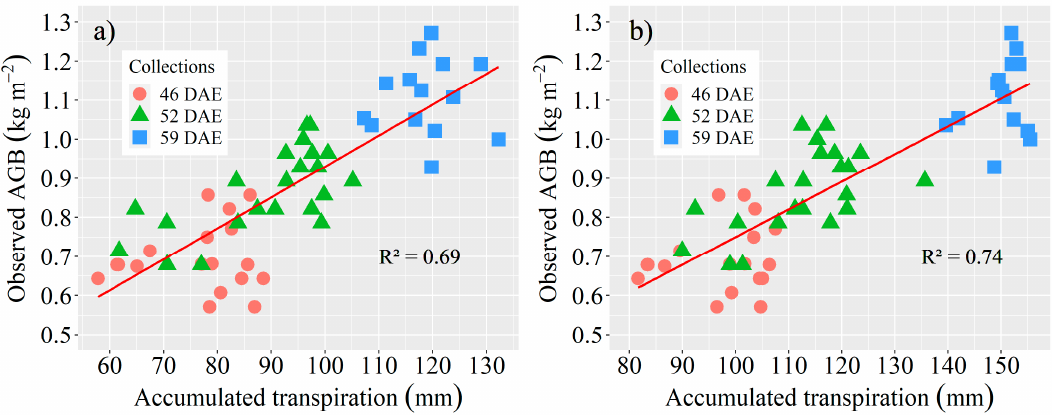
Figure 7. Linear regression between the accumulated actual transpiration (iT a ) of the maize crop (with its biomass) using the models derived from the NDVI ( a ) and SAVI ( b ).